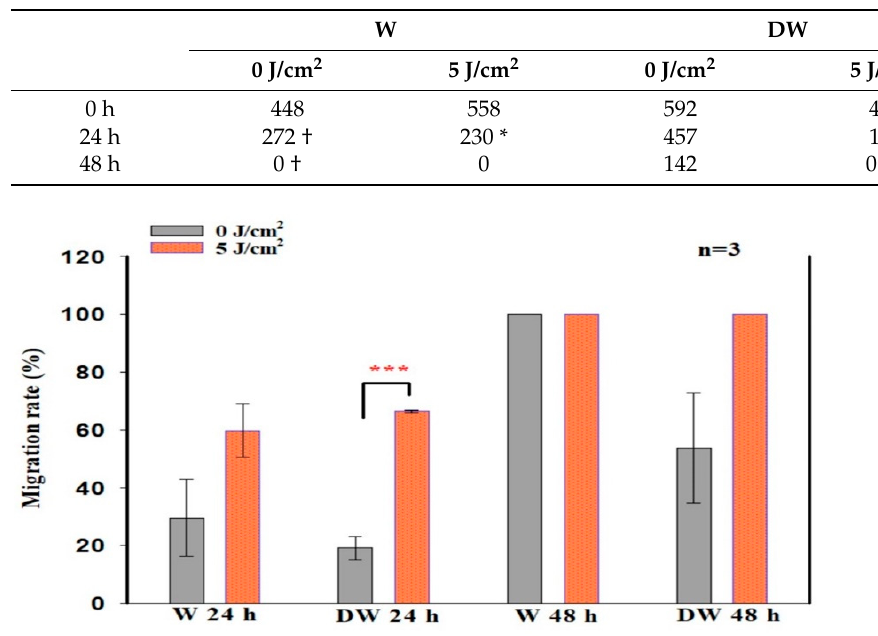
Table 2. Average distance of three repeats of the wound length in µm in wounded (W) and diabetic wounded (DW) cell models (n = 3). Significant probability related to non-irradiated (0 J/cm 2 ) control cells at the same time-point is shown as * p ≤ 0.05 (SEM). Significant probability related to 0 h within cell models is shown as † p ≤ 0.05 and †† p ≤ 0.01 .